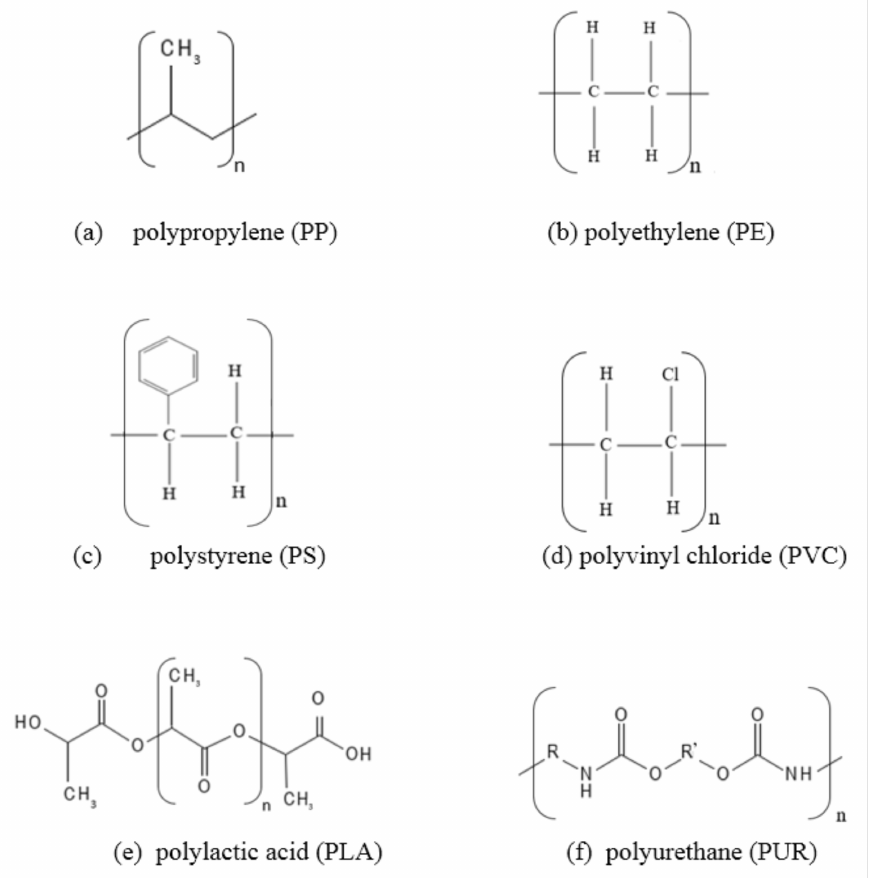
Figure 3. Molecular structures of some of the commonly encountered polymers in soils ( a ) polypropy- lene (PP), ( b ) polyethylene (PE), ( c ) polystyrene (PS), ( d ) polyvinyl chloride (PVC), ( e ) polylactic acid (PLA), ( f ) polyurethane